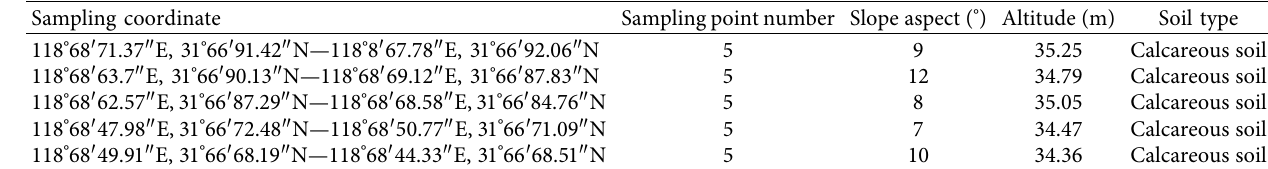
Table 1: Information of sampling points in this study area. Sampling coordinate Sampling point number Slope aspect ( ° ) Altitude (m)